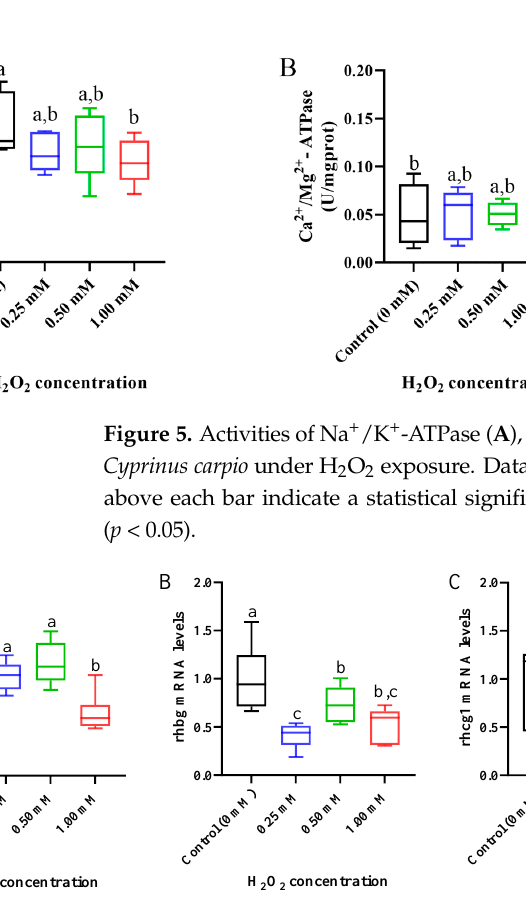
Figure 6. Expression of ion-transport-related genes in gills of Cyprinus carpio under H 2 O 2 exposure. ( A ) Sodium/potassium-transporting ATPase subunit alpha ( nkaa ); ( B ) rhesus glycoprotein B ( rhbg ); ( C ) rhesus glycoproteins C 1 ( rhcg1 ) and ( D ) rhcg2 . Data are expressed as mean ± SE (n = 9). The different letters above each bar indicate a statistical significance among different concentrations of H 2 O 2 exposure ( p < 0.05).